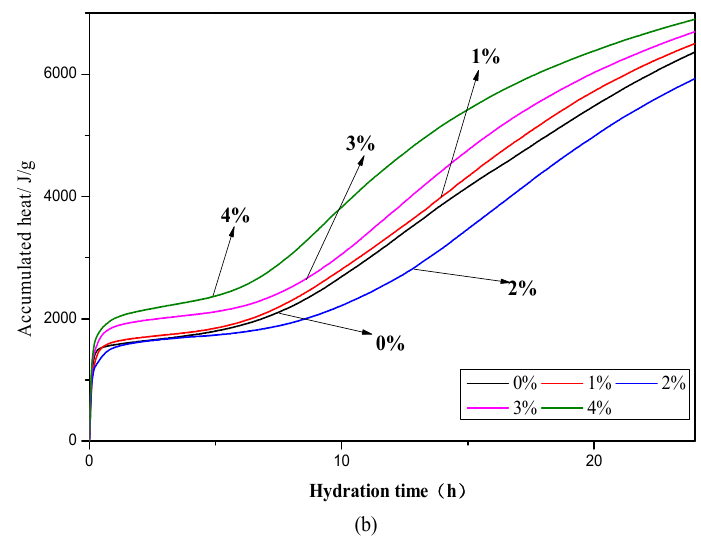
Figure 3. Hydration heat rate ( a ) and accumulated heat ( b ) of the pastes with different contents of NaHCO 3.